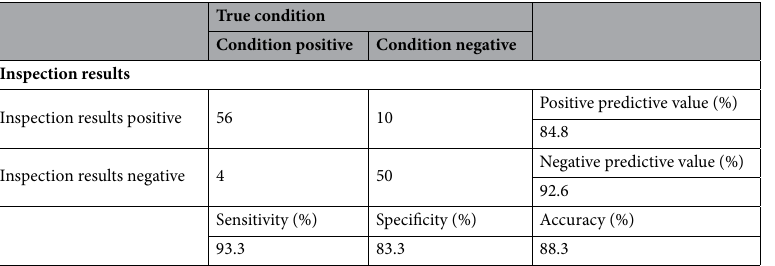
pound list to a few compounds, box charts of each compound were used to compare the areas between BCP and HC. The compounds which were "BCP < HC” and "BCP > HC" were selected. A linear discriminant analysis was performed using the selected compounds. The prediction model built through this procedure used two VOCs in combination, 2-propanol and 2-butanone. As the box plots generated by this model show, 2-butanone was higher in BCP than in HC, while 2-propanol was higher in HC than in BCP (Fig. 2). The obtained discriminant